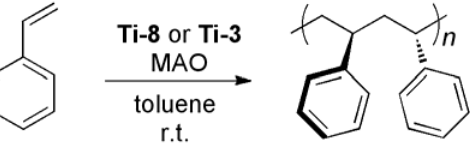
Figure 5. 13 C-NMR spectrum of poly(1-hexene) in C